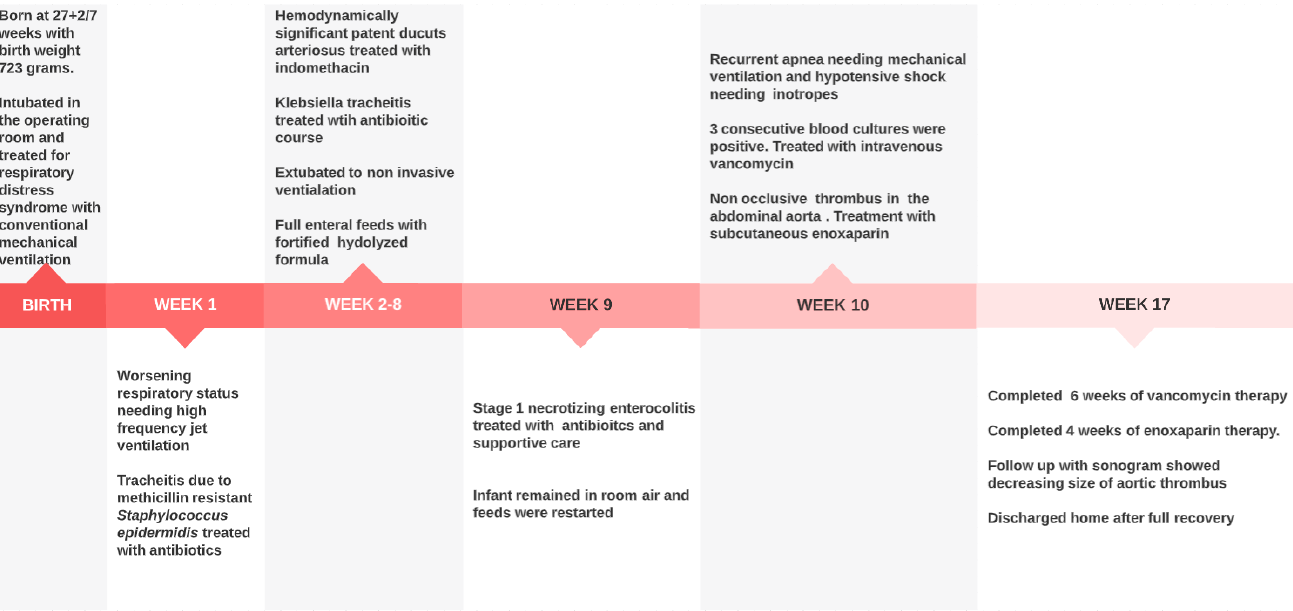
Figure 1. Aortic doppler study showing the non ‐ occlusive thrombus in the grayscale ( a ) and color doppler ( b ).